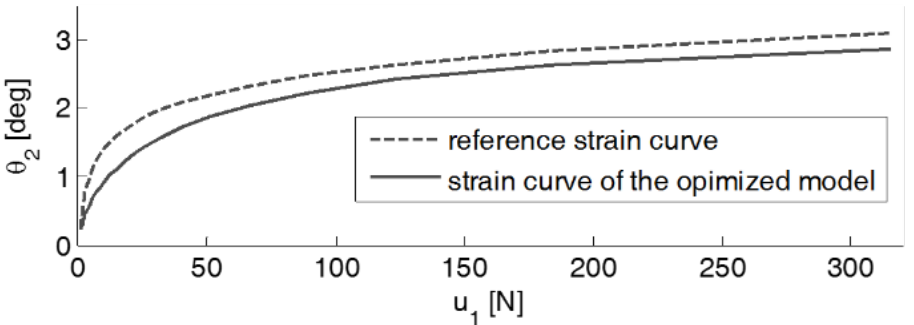
Figure 2. Comparison between the reference and optimized strain curves.